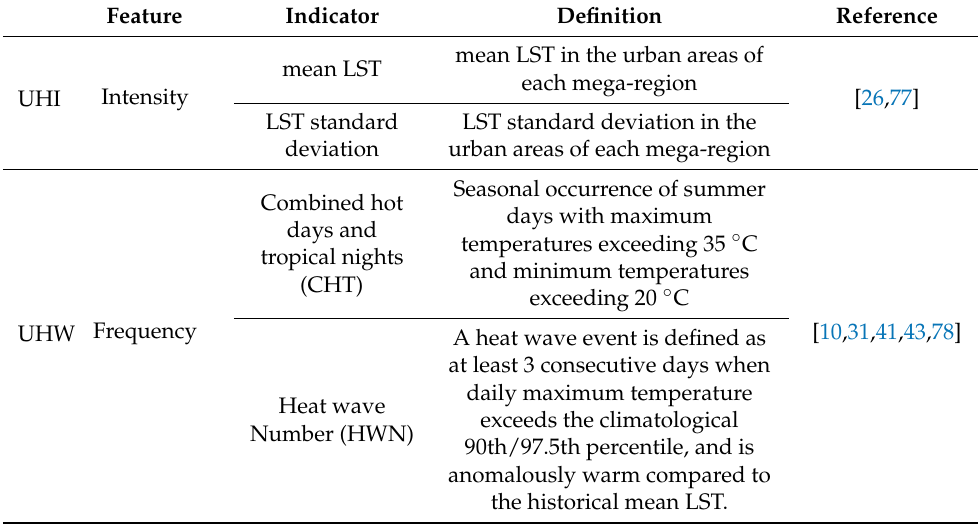
Table 1. Indicators used to characterize UHI and UHW